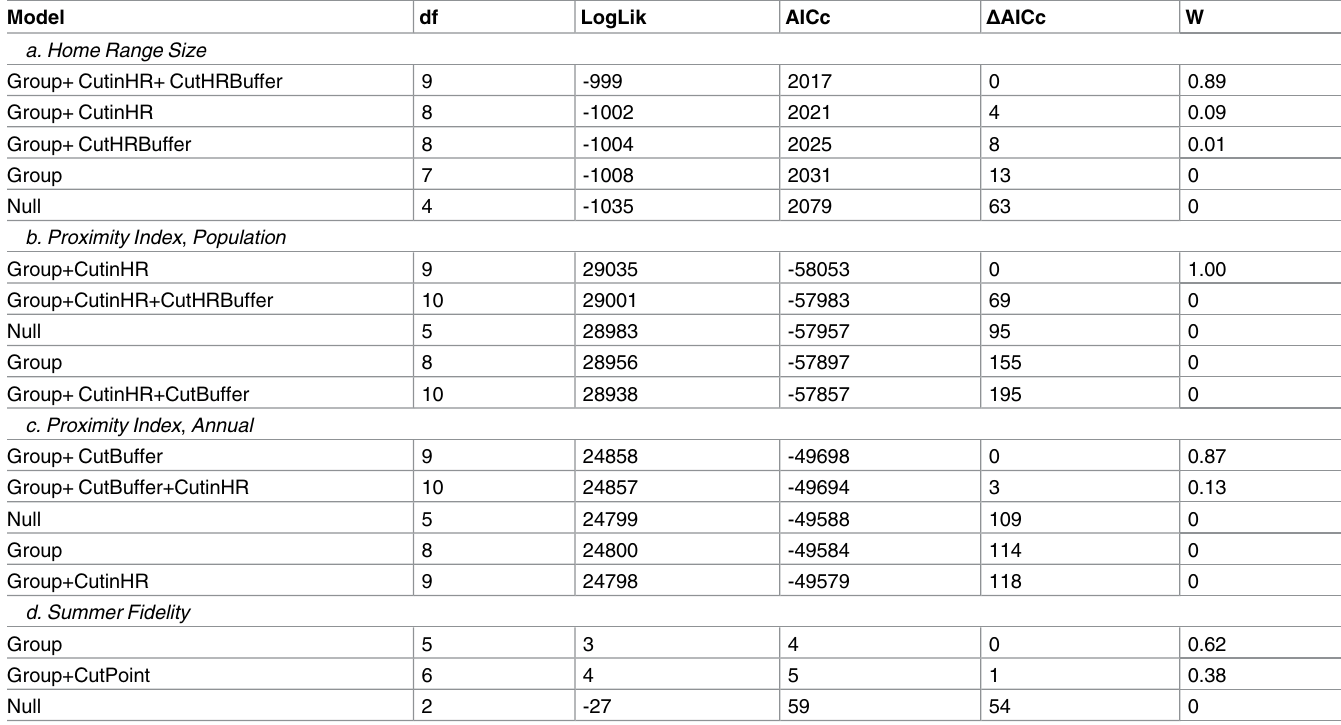
The top 5 candidate models (variable explanations in Table 1) explainingvariation in home range (HR) size (a), population(b) and annual (c) proximity index, and summer fidelity (d) for caribou exposed to changing management in Ontario: the degrees of freedom of each model (df), the natural logarithm of maximum likelihoodfor each model (LogLik), the Akaike’s information criterion adjusted for small sample size bias (AICc), the change in AICc ( Δ AICc), the Akaike weight for each model (W), and variable importance values (i) included when model averagingwas